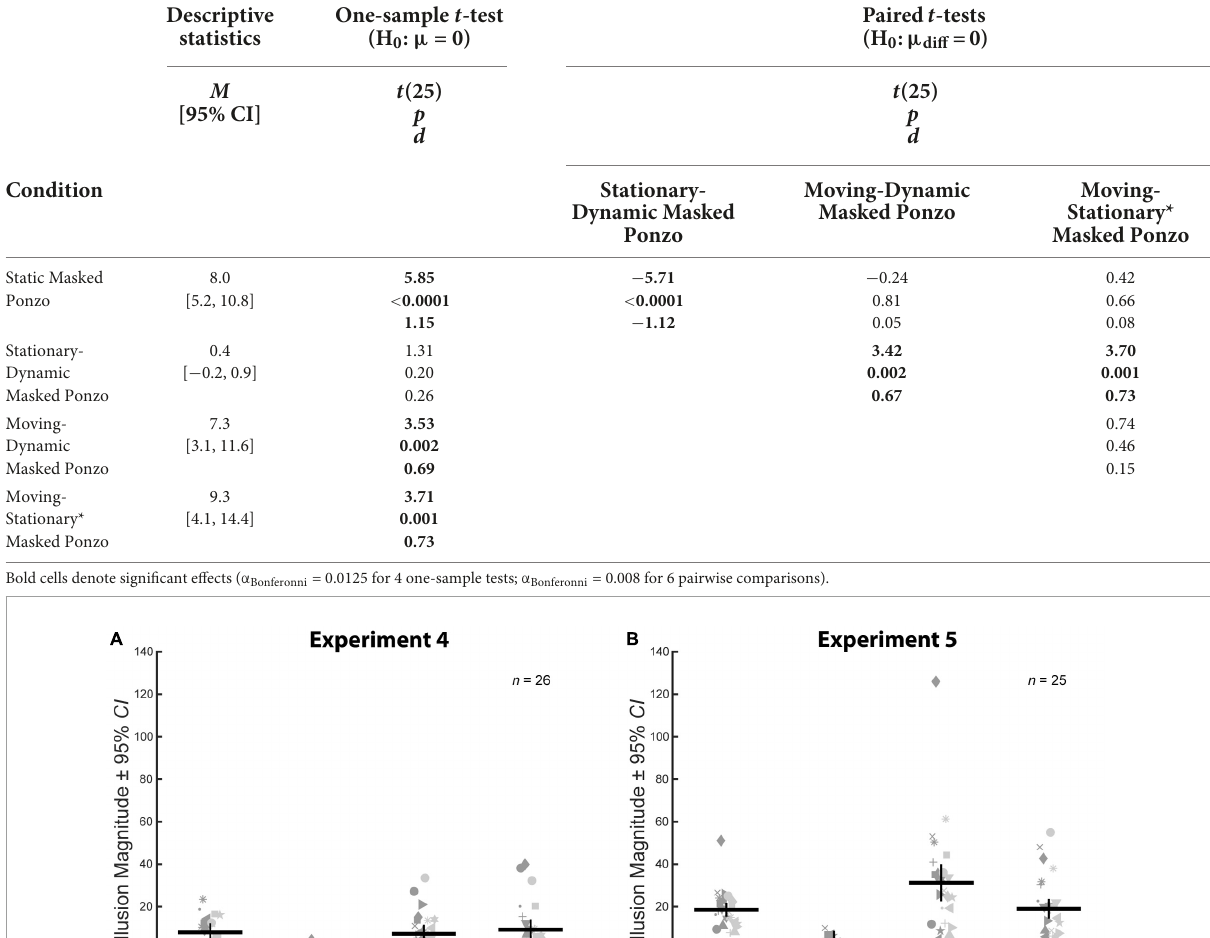
TABLE 4 One-sample and pairwise paired t -tests for all conditions with surrounding context of Experiment 4.